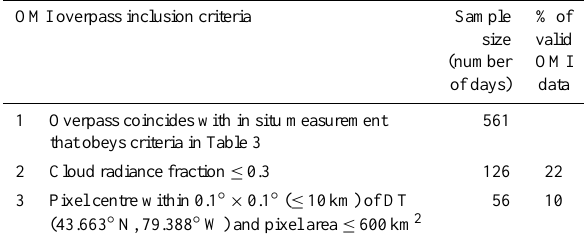
Table 4. Inclusion criteria for OMI measurements. Table 5. Average change in NO 2 concentration at DT and CN, char-